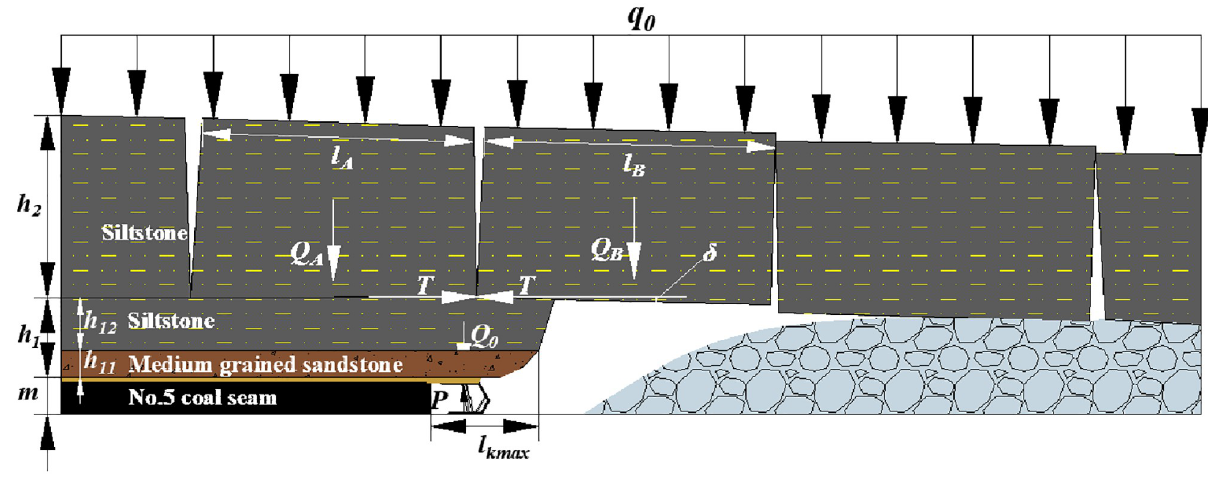
Fig 13. Roof structure characteristic after No.5 coal seam mining.